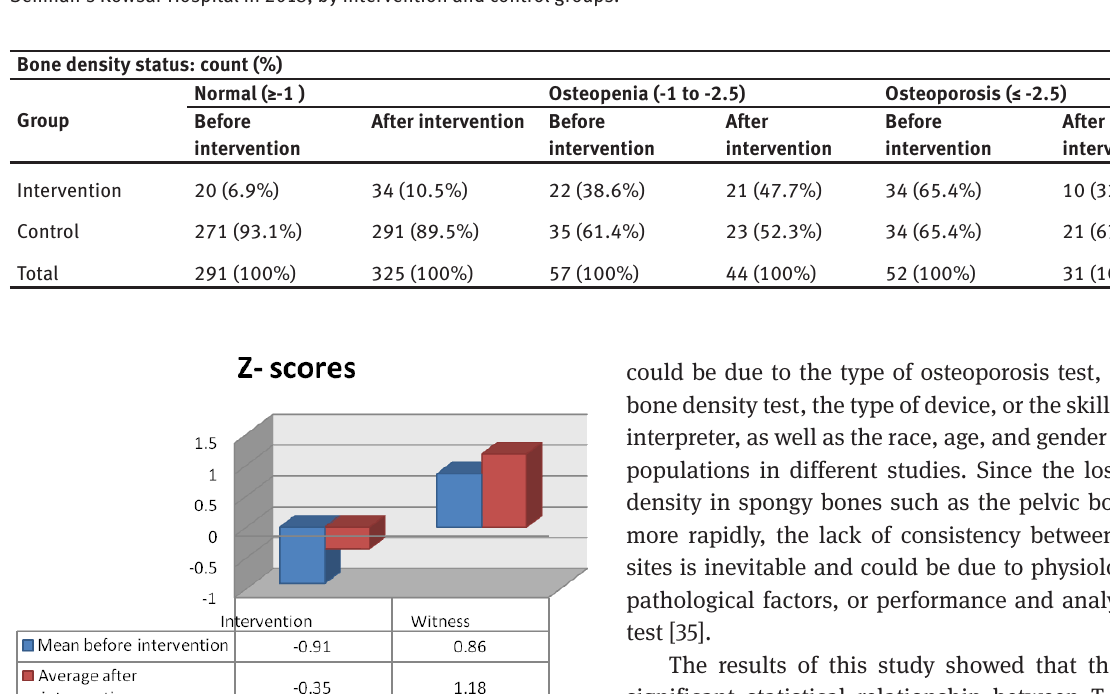
Table 3: Count distribution and frequency percentage of different statuses in BMD test of patients referred to The Bone Density Clinic of Semnan’s Kowsar Hospital in 2018, by intervention and control groups.